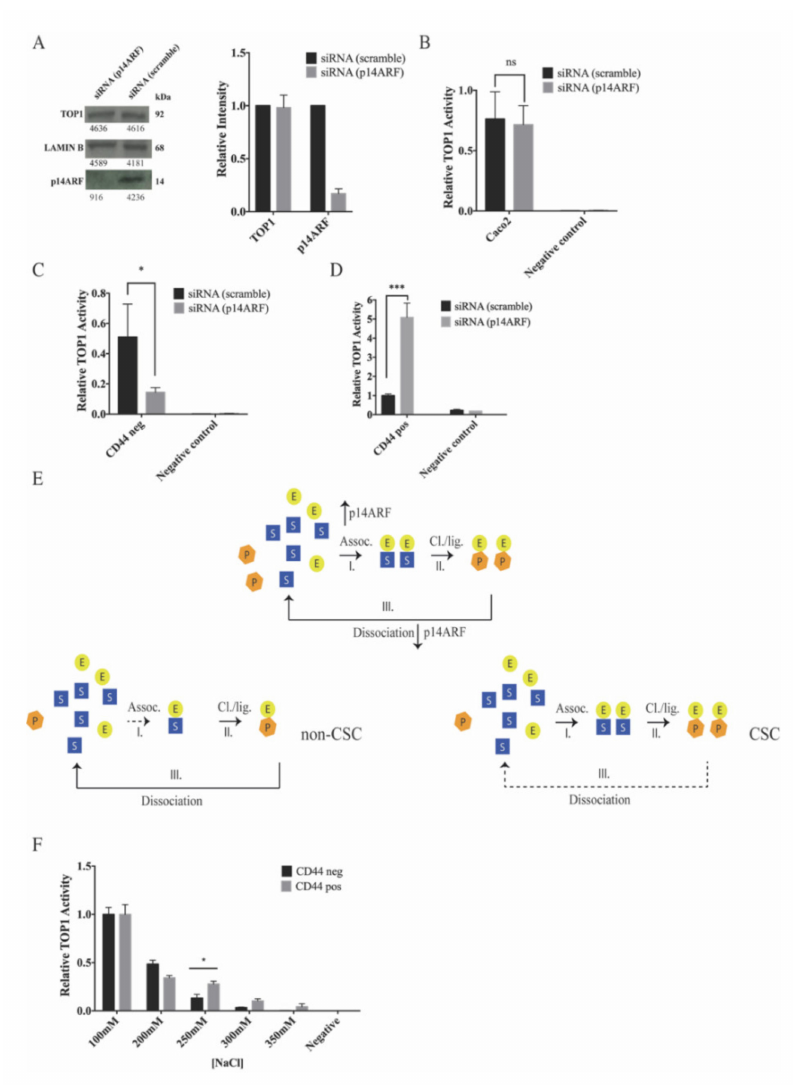
Figure 4. Effect of p14ARF downregulation on topoisomerase 1 activity. ( A ) Left panel, Western blot analysis of whole cell extracts from unsorted Caco2 cells transfected with scrambled siRNA (siRNA (scramble)) or p14ARF specific siRNA (siRNA (p14ARF)) developed by using anti-TOP1, anti-p14ARF, or anti-LAMIN B antibodies. Right panel, graphical depiction showing the results of the densitometrically quantified bands shown in the Western blot. The intensity of the p14ARF or TOP1 specific bands was normalized relative to the intensity of the LAMIN B bands. Data were plotted as mean +/ − standard error of the mean (SEM). ( B ) Measurement of TOP1 activity by rolling-circle enhanced enzyme activity detection (REEAD) in whole cell extracts from Caco2 cells transfected with siRNA (scramble) (black bars) or siRNA (p14ARF) (grey bars). The REEAD signals detected on an average of 12 microscopic images were counted using the ImageJ software and the result was normalized against the number of signals obtained by analyzing the activity of purified TOP1. The signals were normalized as reported by Stougaard et al. [50]. All data were plotted as mean +/ − SEM, ns = not significative, Welch’s test, n = 6. ( C ) Same as ( B ), except that non-CSC-like cells (CD44 negative) were analyzed. The non-CSC-like cells were obtained by treating the cells with NaBt, giving approx. 100% CD44 negative cells. The data were plotted as mean +/ − SEM. * p = 0.03, Welch’s test, n = 6. ( D ) Measurement of TOP1 activity in the whole cell extracts from Caco2 CSC-like (CD44 positive) cells transfected with siRNA (scramble) (black bars) or siRNA (p14ARF) (grey bars). The CSC-like (CD44 positive) cells were captured onto a glass slide by using anti-CD44 antibody and the TOP1 activity measured by using the On-Slide-REEAD as described by Keller et al. [51]. The REEAD signals were counted using